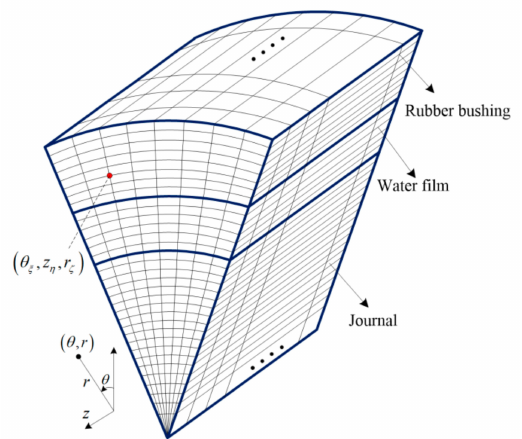
Figure 4. Meshed journal, water film, and rubber bushing (JWR) system in polar